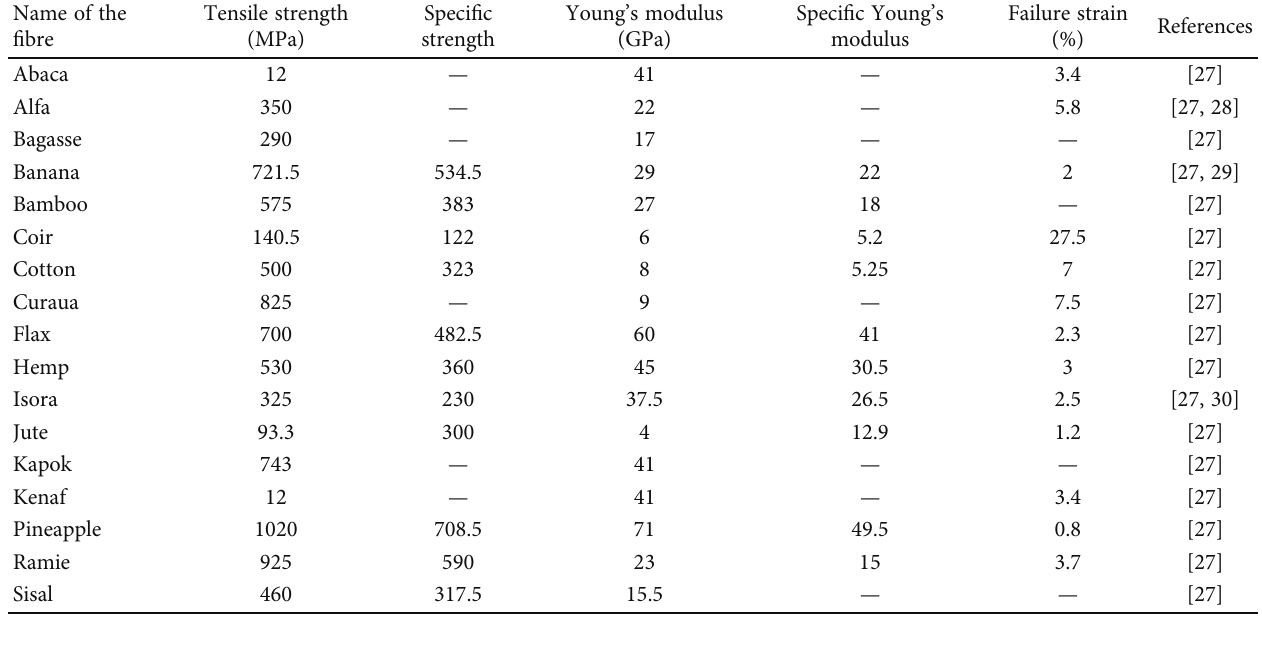
Table 3: Mechanical properties of natural fi bres.